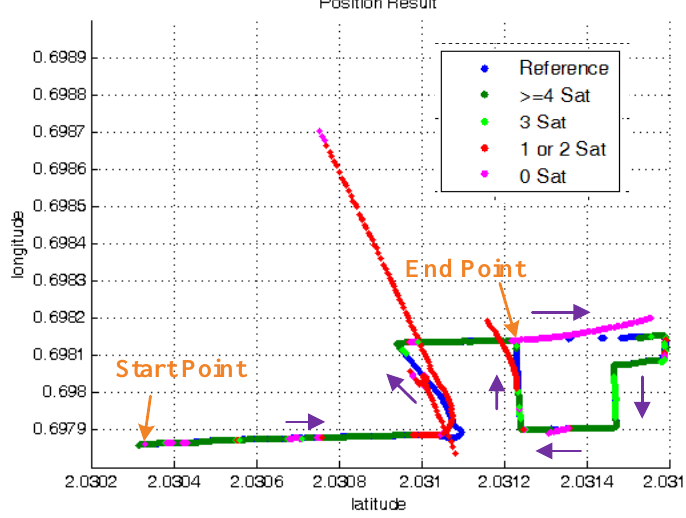
Figure 13. Standard tightly-coupled position